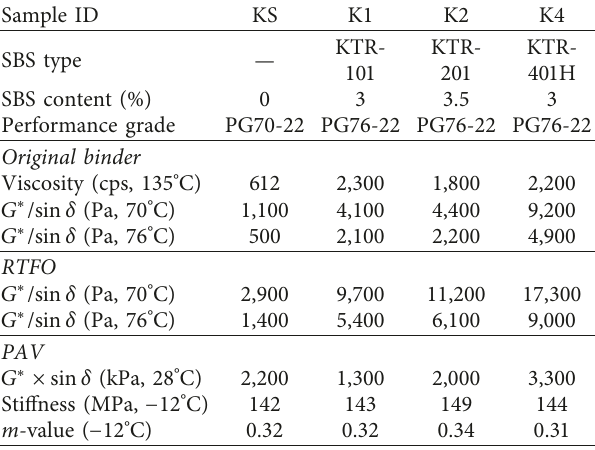
Figure 1: Mixtures gradation chart. Table 1: Asphalt binder test results for Superpave